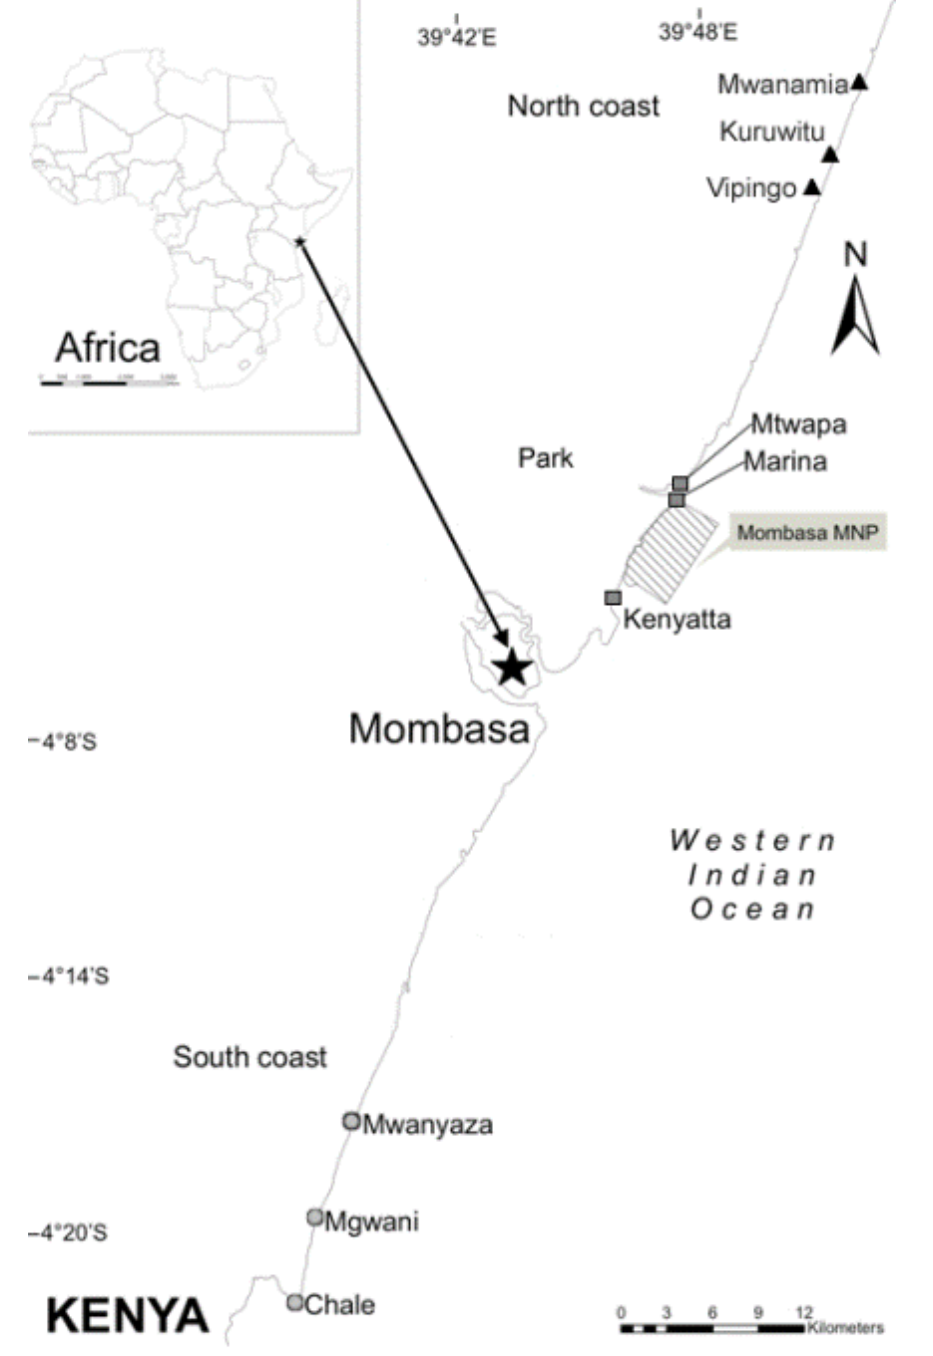
Fig. 1. Map of the southern Kenyan coastline showing the nine study sites. Community (black triangle), Government (dark-gray square), Co- (light-gray